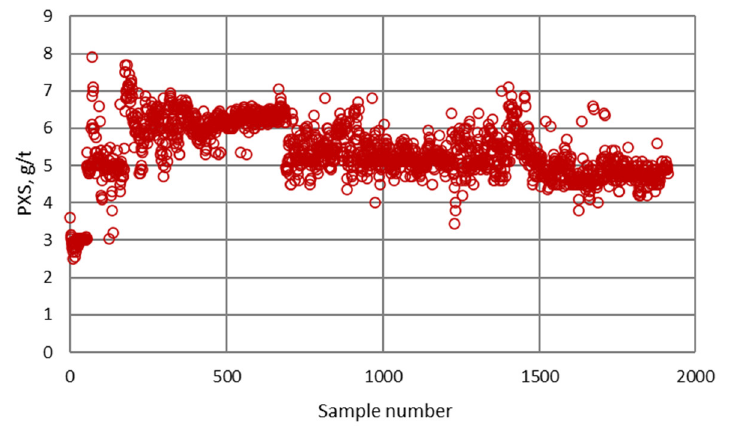
Figure A9. Collector consumption in scavenger flotation stage (PXS)—input dataset.